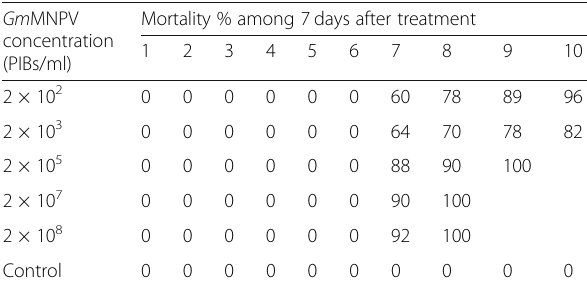
Table 1 Mortality percent among larvae (L 3 ) of G. mellonella on diet treated with different concentrations of Gm